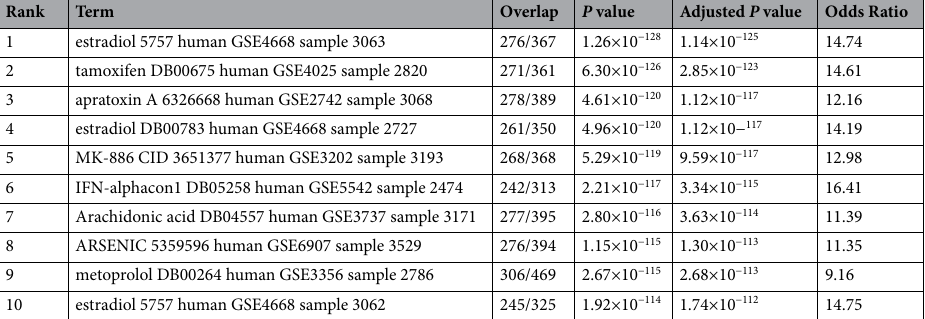
Table 5. Drug perturbations from GEO